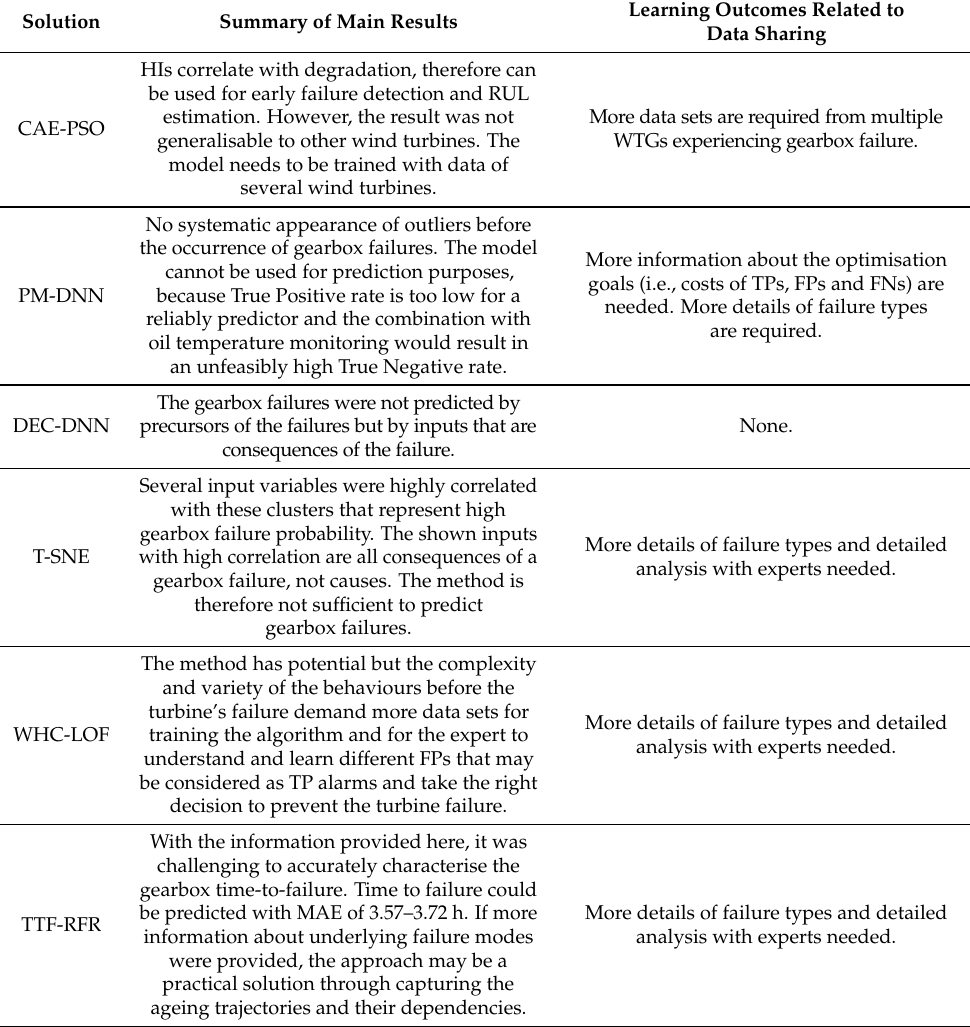
Table 4. Summary of main results and learning outcomes. Solution Summary of Main Results